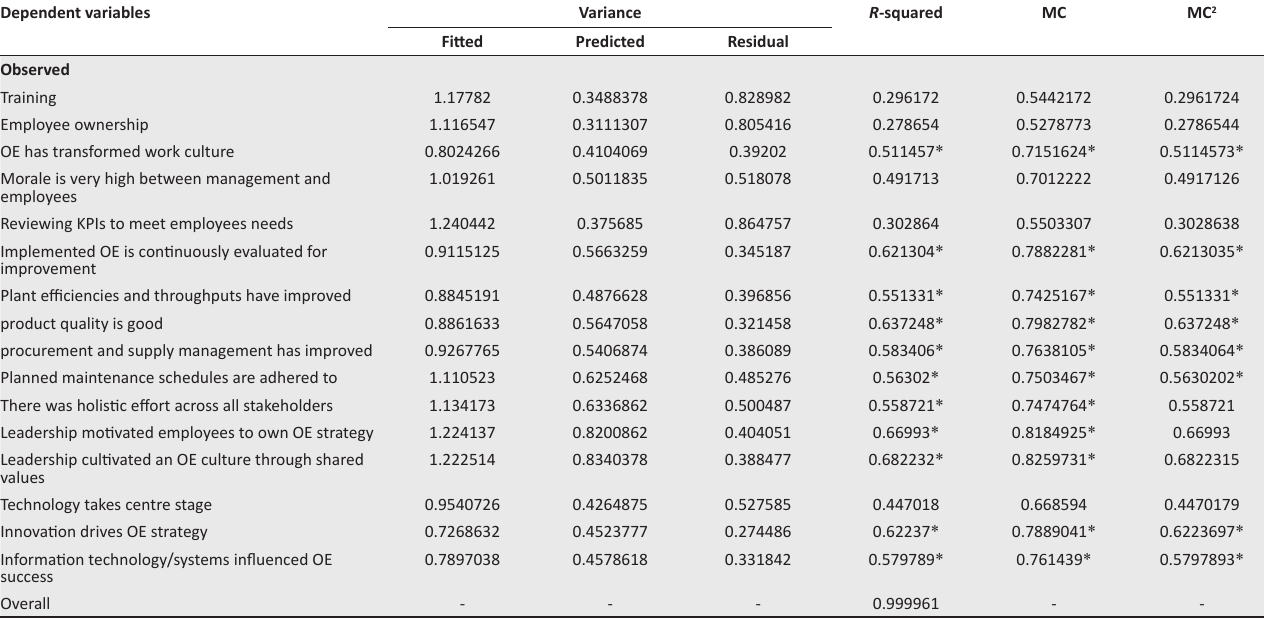
TABLE 4 : The goodness of fit at equation